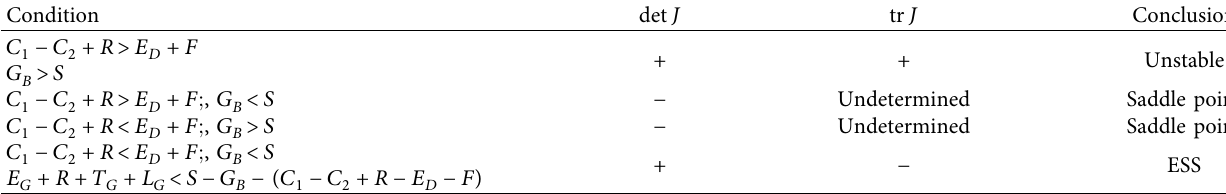
Table 3: Stability discussion of point D (1, 0, 0).